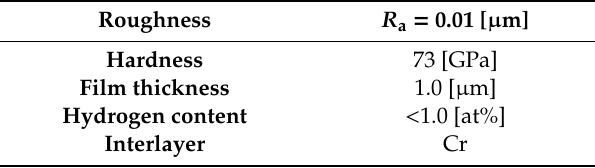
Table 3. Physical properties of the ta-C